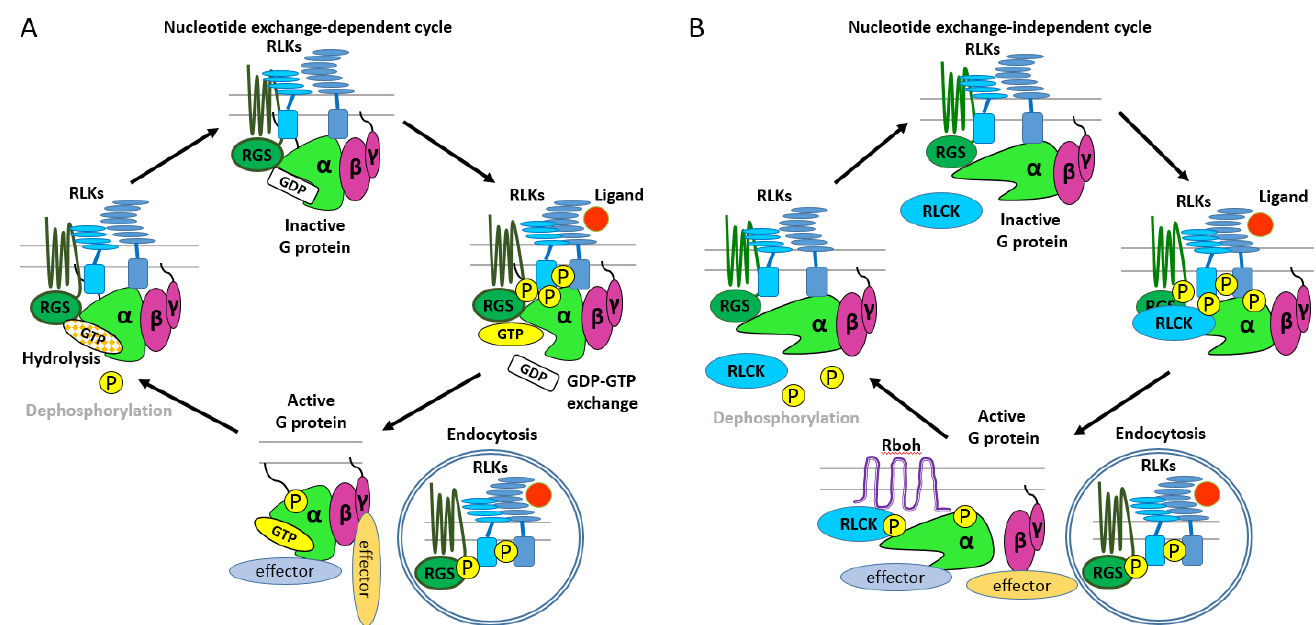
Figure 3. Model for heterotrimeric G protein signalling in plants. ( A ) Nucleotide exchange-dependent cycle. The heterotrimer consisting of GDP-bound canonical G α and the G βγ dimer is associated with a 7TM-RGS and RLKs at the plasma membrane in its resting state. Upon ligand binding, RLKs phosphorylate G α and RGS. Ligand binding is followed by receptor and RGS endocytosis and subsequent de-repression of G α , which releases GDP and binds GTP. GTP-bound G α does not necessarily separate from G βγ , and each of the two components modulate downstream signalling cascades. Dephosphorylation (research is urgently needed) and binding to a new RGS leads to GTP hydrolysis terminating signalling and returning the heterotrimer to the inactive state. ( B ) Nucleotide exchange-independent cycle. The heterotrimer consisting of either canonical G α or XLG and the G βγ dimer is associated with a 7TM-RGS (the role of RGS here is yet to be determined), RLKs, and RLCKs at the plasma membrane in its resting state. Upon ligand binding, RLKs phosphorylate G α /XLG, RGS, and RLCKs. Ligand binding is followed by receptor endocytosis. Here, activation could be caused by de-repression or phosphorylation-mediated activation of G α /XLG or G βγ (the activation mechanism is not established). In case of Arabidopsis, XLG2 dissociates from G βγ upon perception of flg22 [85]. Both G α /XLG and G βγ modulate downstream signalling cascades. One example of effector activation is the BIK1/XLG2-mediated activation of RbohD [85]. Hypothetically, dephosphorylation (research is urgently needed) leads to signal termination and reassociation of the heterotrimer into the inactive state.